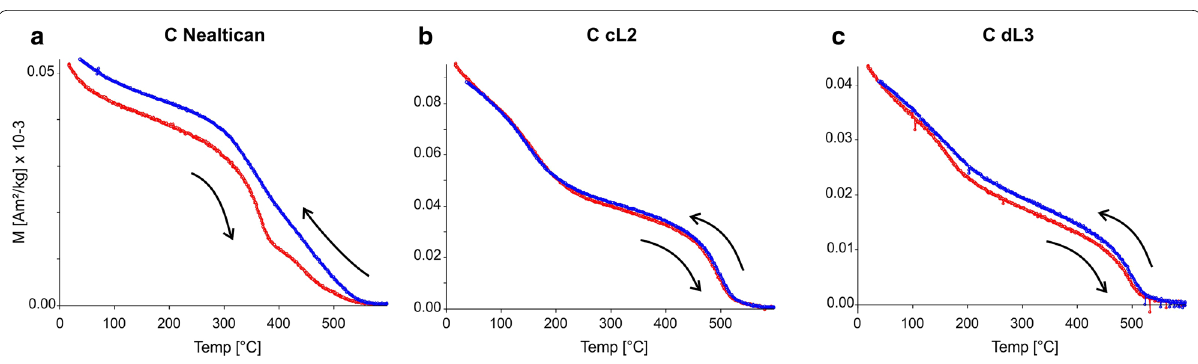
Fig. 12 High‑field‑induced magnetization versus temperature (M–T) plots for the three ceramic fragments ( a – c ) studied from